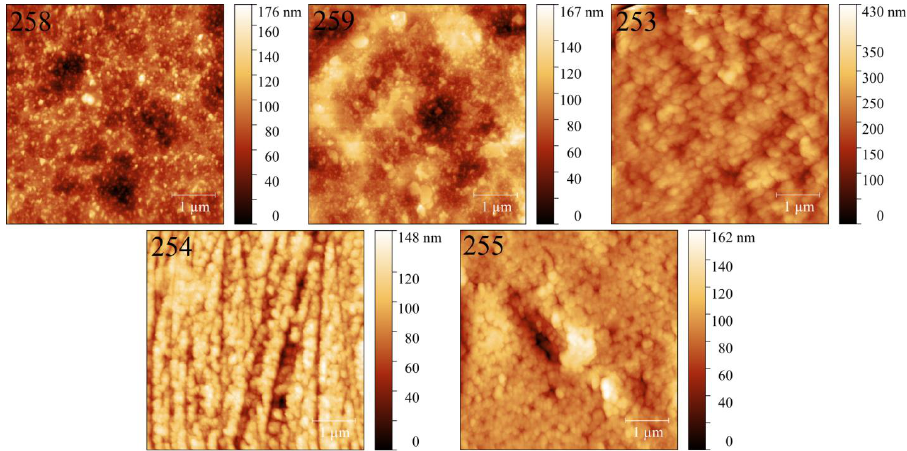
Figure 2. AFM images of the por-Si samples with different porosities (arranged according to the increase in the porosity index).